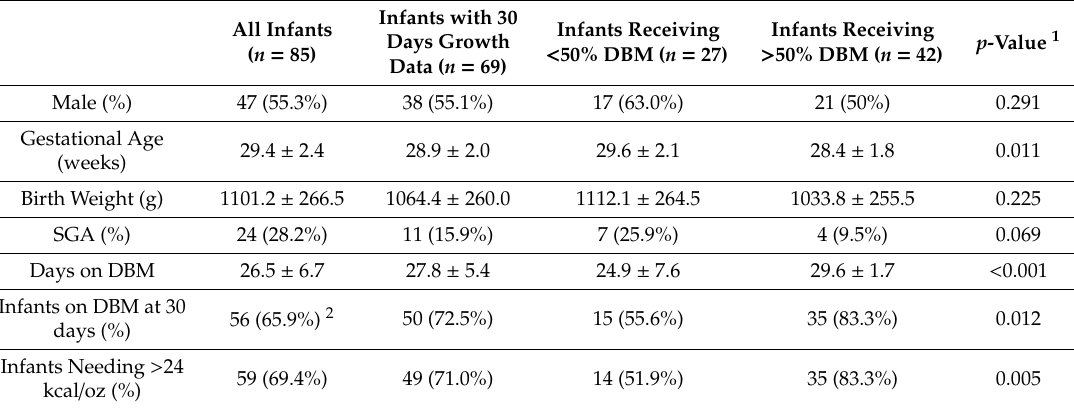
Figure 1. Flow diagram of study infants. Table 1. Infant characteristics. Mean ± SD or n (%).